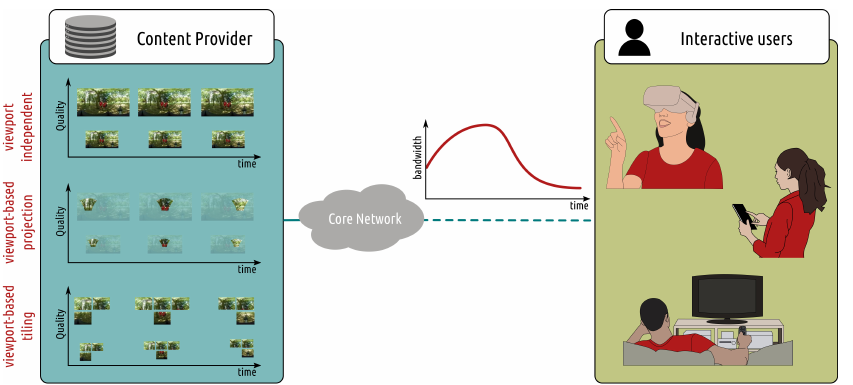
Figure 6. Visualization of different adaptive streaming strategies for interactive systems. In the viewport-independent case, the entire panorama is encoded at multiple quality levels and resolutions and fully sent to final users. The other two approaches are viewport-dependent ones, in which either areas of interest in the panorama are encoded at high quality (viewport-based projection) or the panorama is encoded into multiple tiles and the tiles covering the area to be visualized will be downloaded at higher quality (viewport-based